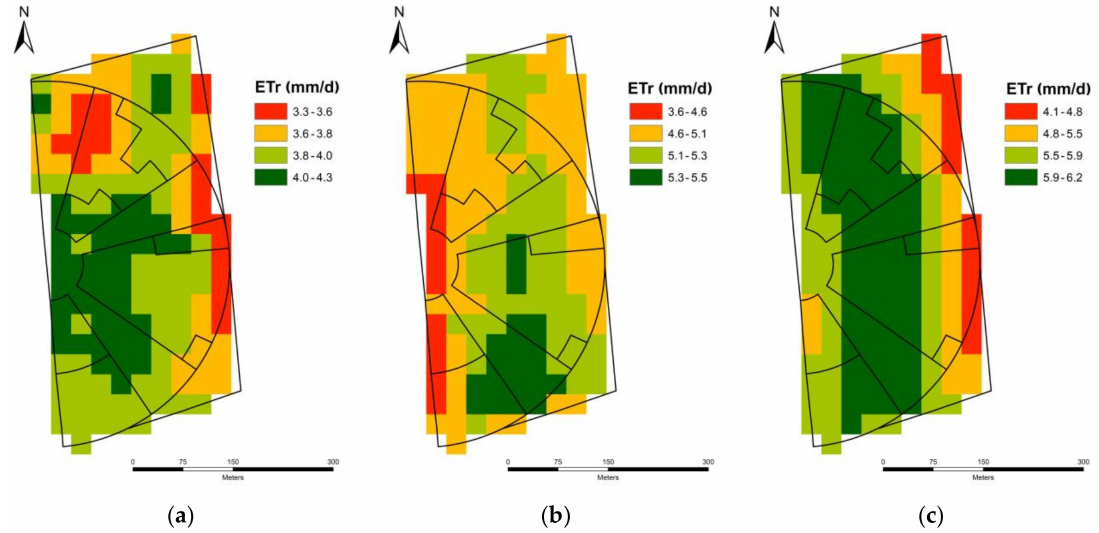
Figure 8. Temporal variability in SEBAL actual evapotranspiration (ETr) maps on June 2nd ( a ), July 2nd ( b ) and August 6th, 2015 ( c